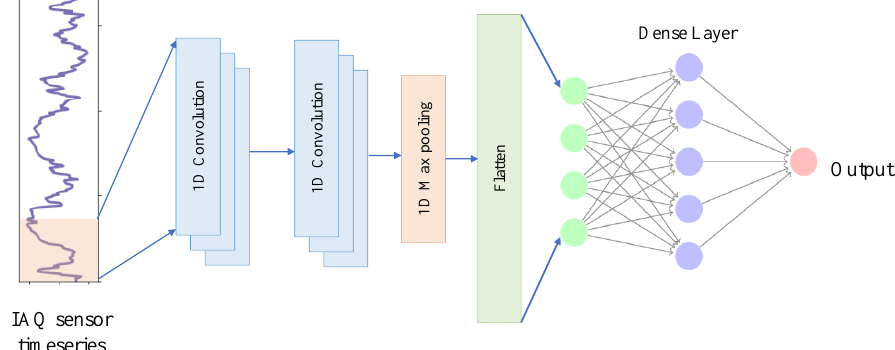
Figure 6. The convolutional neural network (CNN) model architecture for forecasting IAQ sensor data.